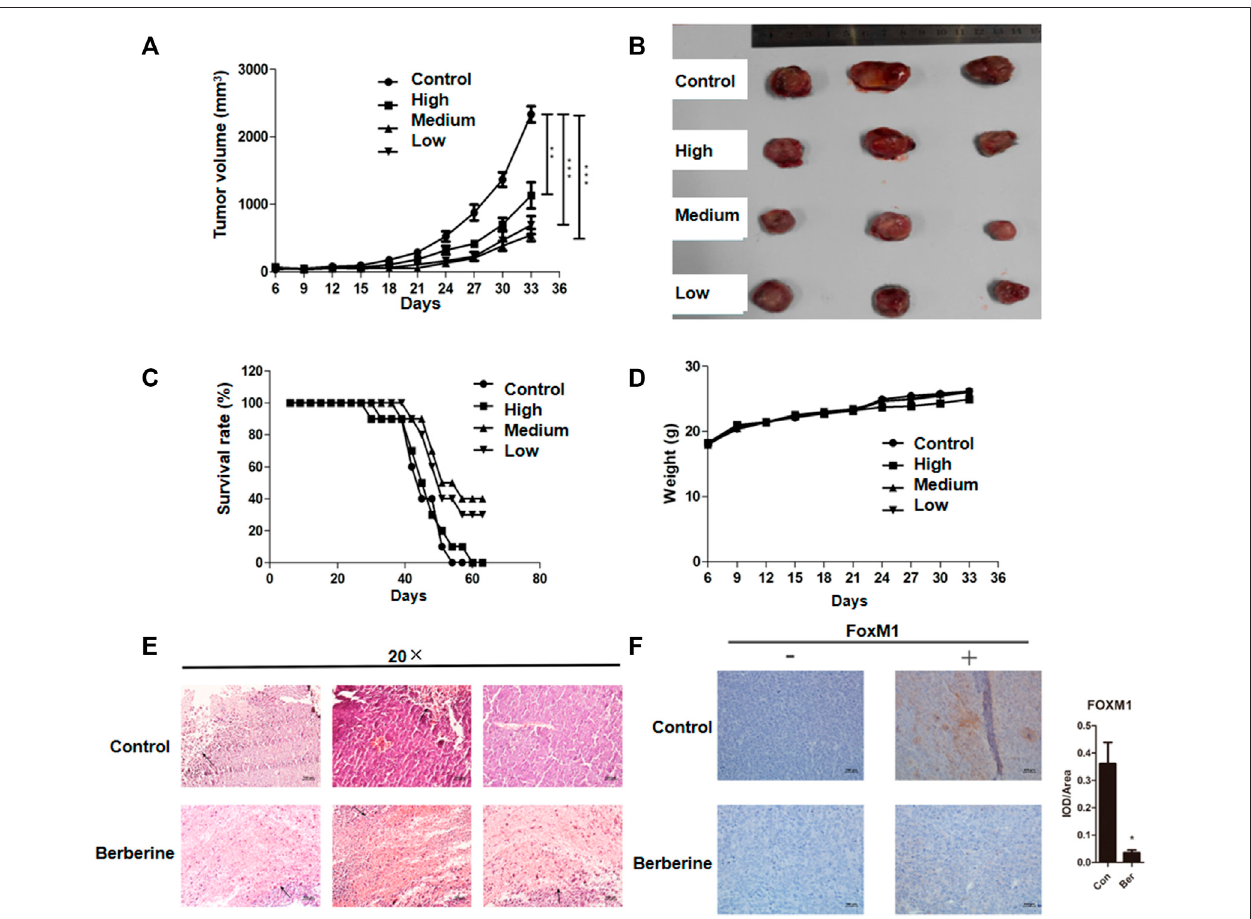
FIGURE 5 | Berberine inhibited the survival of lung cancer xenografts and down regulated the expression of FOXM1 in vivo . (A) Tumor volume. (B) Tumor photos. (C) Survival. (D) Weight. (E) HE staining of the tumor (The area indicated by the arrow was the tumor necrosis area in mice.) (F) Compared with the blank control group, the expression levels of tumor FOXM1 in mice in the medium concentration berberine group were relatively signi fi cantly reduced ( “ − ” refers to the absence of a correspondingantibody,while “ + ” referstothecorresponding antibody).Dataarepresentedasmean±SEMfromthreeindependentexperiments.* p < 0.05;** p < 0.01; *** p < 0.001, compared with the control